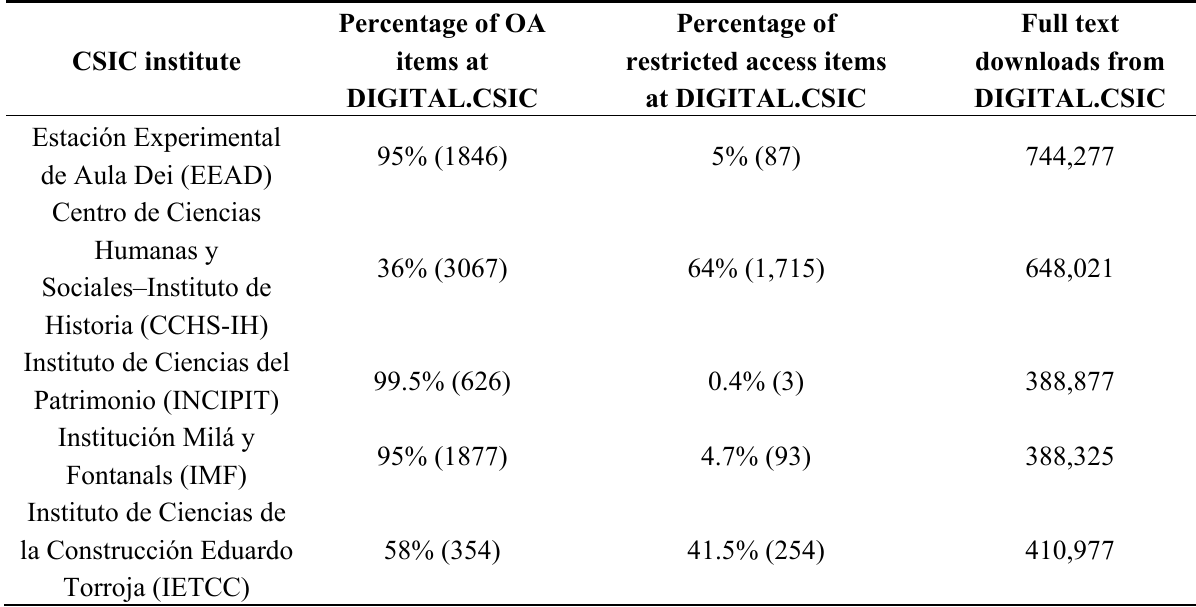
Table 1. Openness degree in collections of CSIC institutes with the highest number of downloads at DIGITAL.CSIC (totals).